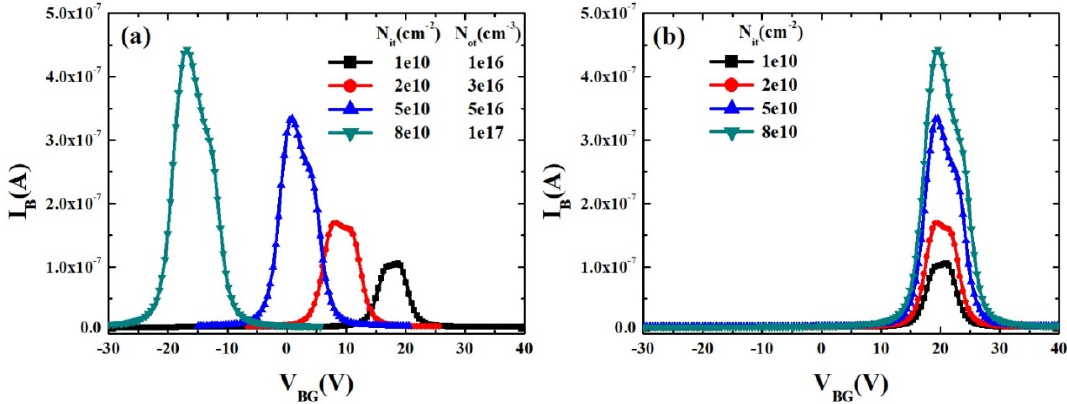
Figure 5. Simulated I B -V BG characteristics ( a ) with varying interface trap densities from 1 × 10 10 cm − 2 to 8 × 10 10 cm − 2 and oxide trap densities from 1 × 10 10 cm − 3 to 1 × 10 10 cm − 3 ( b ) with varying interface trap densities from 1 × 10 10 cm − 2 to 8 × 10 10 cm − 2 .